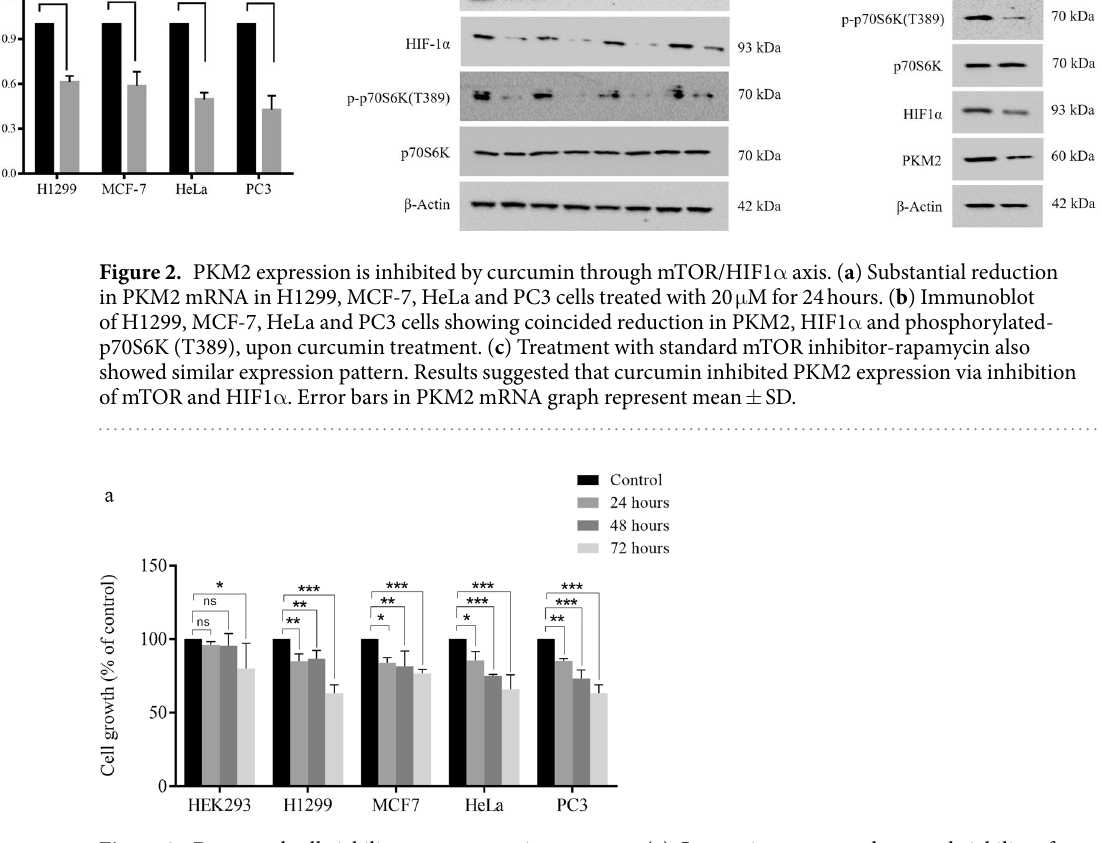
Figure 3. Decreased cell viability upon curcumin treatment. ( a ) Curcumin treatment decreased viability of H1299, MCF-7, HeLa and PC3 cells over the time course of 24, 48 and 72 hours. Decrease in viability of four cancer cell lines is significantly higher compared to control HEK293 cells. Maximum decrease in viability of all studied cell lines was observed at 72 hours. Error bars represent mean ±